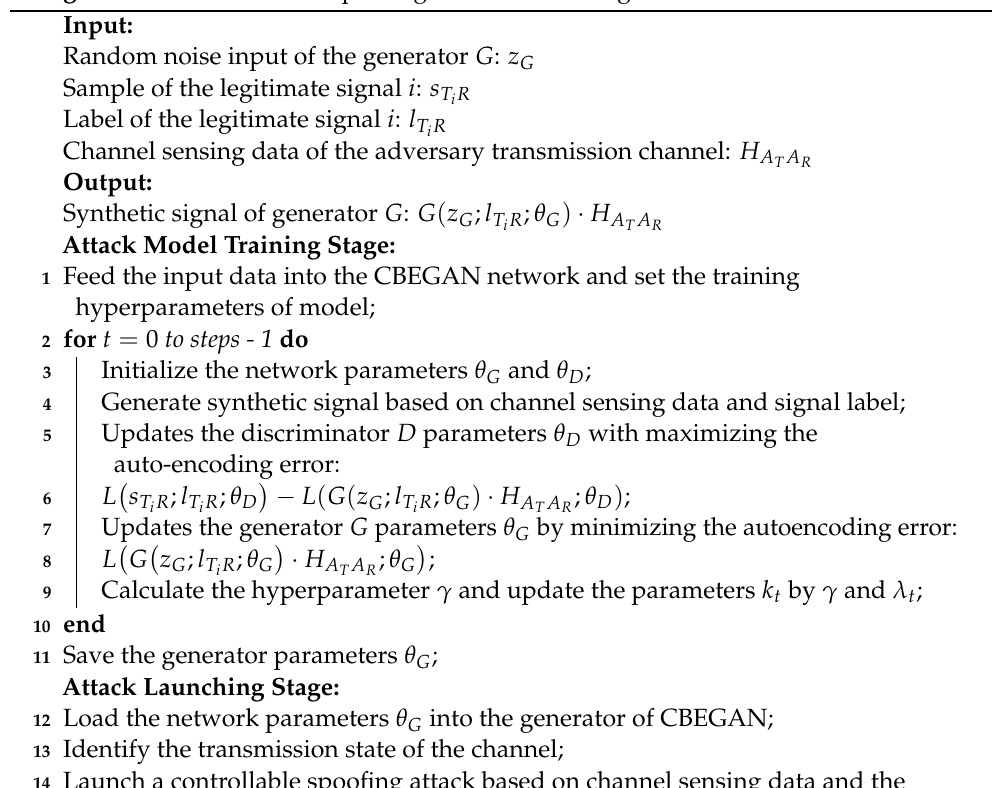
Algorithm 1: Controllable Spoofing Attack Launching